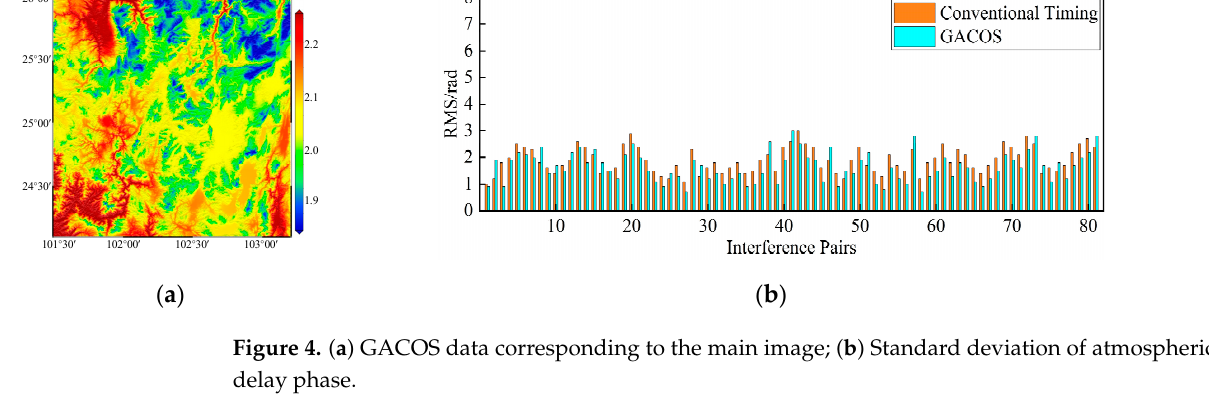
Figure 3. Time-position of Sentinel-1A image interferometric pairs. Blue line represents the inter- ferometric pairs. The red points are the master and slave Synthetic Aperture Radar (SAR) images.